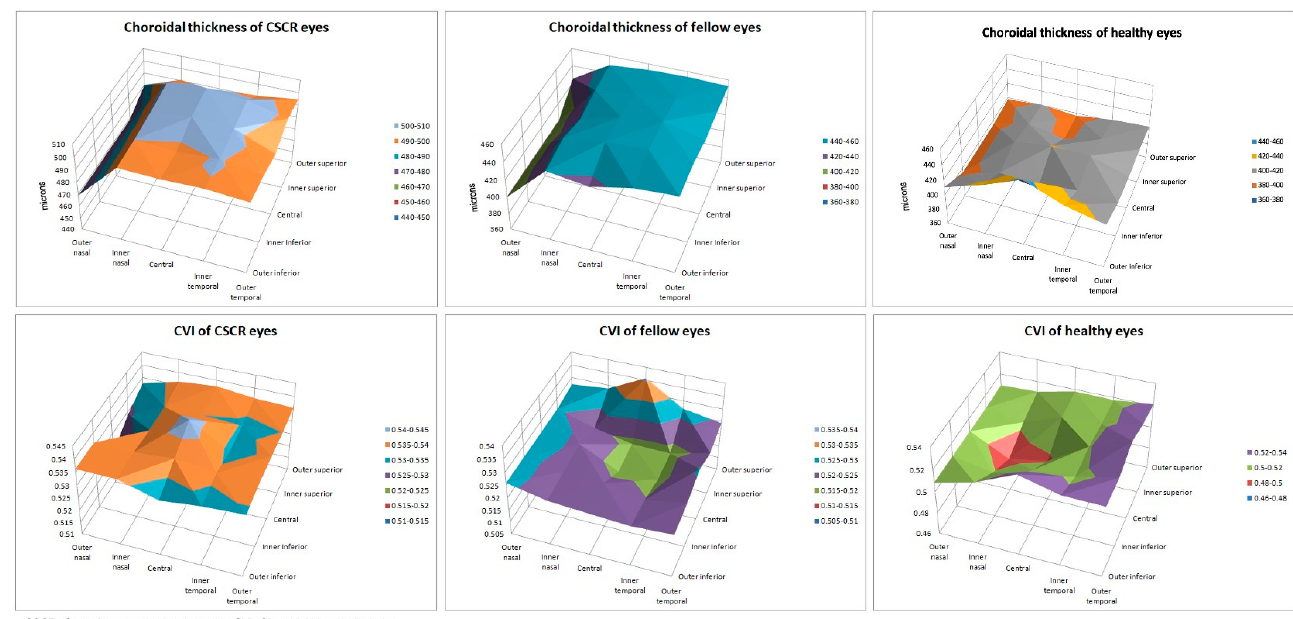
Figure 2. Chart showing comparison of choroidal thickness and choroidal vascularity index of CSCR and fellow eyes.